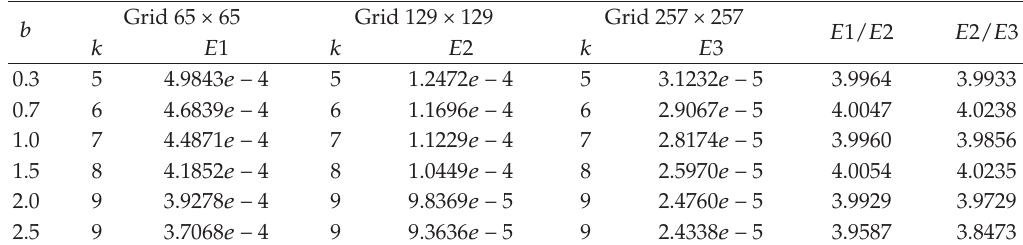
Table 6: Convergence of the method in Example 4.4 for a (cid:10) 1.